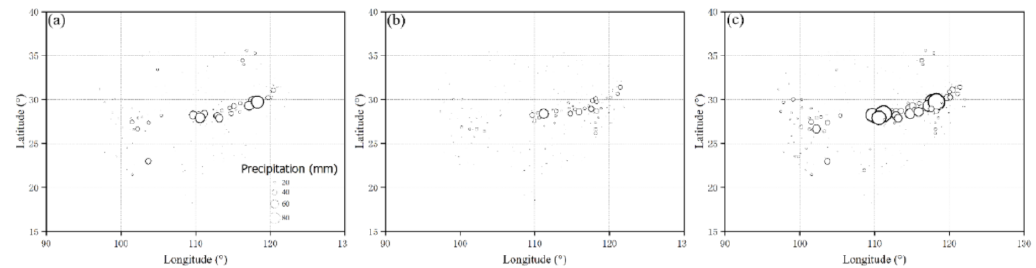
Figure A3. The precipitation recorded by the ground meteorological stations at the 197th day in 2014 across South China. ( a ) the total precipitation in the period of 20:00-08:00. ( b ) the total precipitation in the period of 08:00-20:00. ( c ) the total precipitation of both ( a ) and ( b ). The precipitation data is downloaded from China Meteorological Administration ().